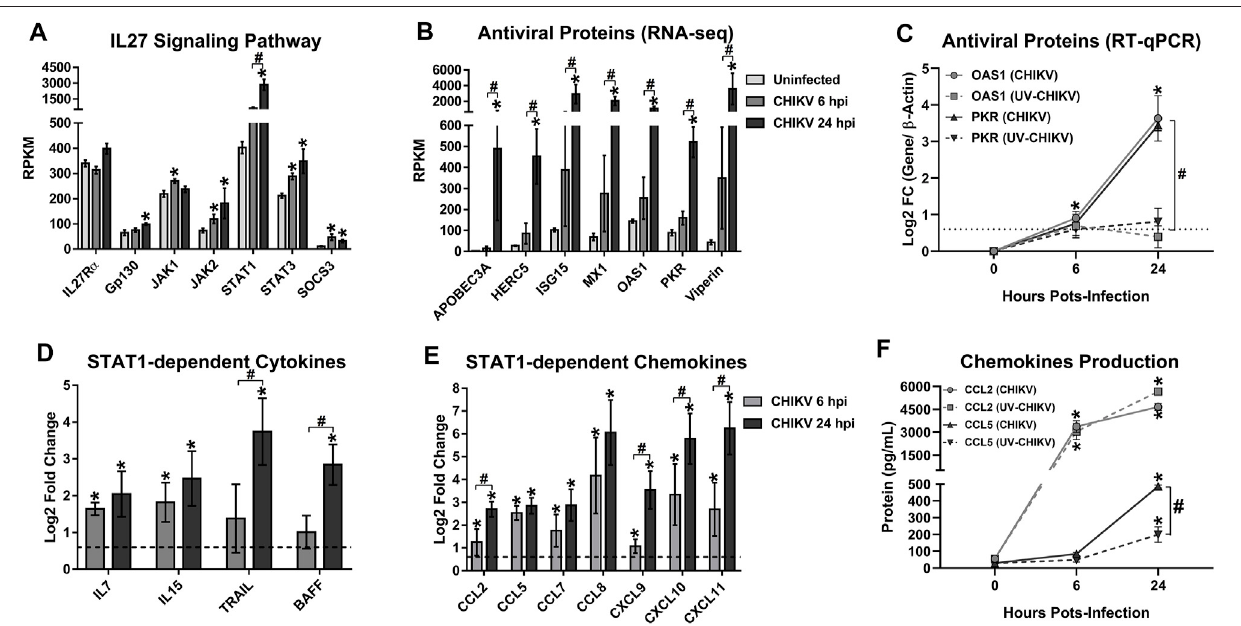
FIGURE 6 | CHIKV-infected MDMs trigger a robust STAT1-dependent pro-in fl ammatory and antiviral response. Human MDMs cultures were left uninfected or infected with CHIKV at MOI 5. Cell lysates were obtained at 6 and 24 hpi, and RNA-seq was performed. mRNA abundance (RPKM) of IL27 signaling pathway components (A) and AVPs (B) , in uninfected and CHIKV-infected MDMs. Data are presented as the mean ± SEM. Kruskal – Wallis test with Dunn ’ s post-test was performed.Signi fi cantresultsbetweenuninfectedandCHIKV-infectedMDMsarede fi nedas p < 0.05(*), p < 0.01(**)and p < 0.002(***).Signi fi cantresultsbetween treatment-timescomparisonsarede fi nedas p < 0.05(#), p < 0.01(##)and p < 0.002(###).Differentiallyexpressed(Log2FC)STAT1-dependentcytokines (D) ,CC – and CXC-chemokines (E) , in CHIKV-infected MDMs. DEG was de fi ned as genes with an FDR < 0.05 and |Log2 Fold Change (CHIKV-infected MDMs/Uninfected MDMs) | > 0.6. Signi fi cantresults arede fi ned as p < 0.05 (*), p < 0.01 (**)and p < 0.002(***).n= 4.Human MDMscultures wereinfected at MOI 5ofCHIKV or anon-replicativeUV- inactivatedCHIKV(UV-CHIKV).AVPs(OAS1andPKR)mRNAexpression(Log2FC) (C) ,andSTAT1-dependentCC-chemokinesproduction(CCL2andCCL5) (F) were evaluated at 0, 6 and 24 hpi, by RT-qPCR and ELISA, respectively. Data are presented as the mean ± SEM. Kruskal – Wallis test with Dunn ’ s post-test was performed. Signi fi cant results between uninfected and CHIKV- or UV-CHIKV-infected MDMs are de fi ned as p < 0.05 (*), p < 0.01 (**) and p < 0.002 (***). Signi fi cant results between CHIKV-infected MDMs and UV-CHIKV-infected MDMs are de fi ned as p < 0.05 (#), p < 0.01 (##) and p < 0.002 (###). n = 4.